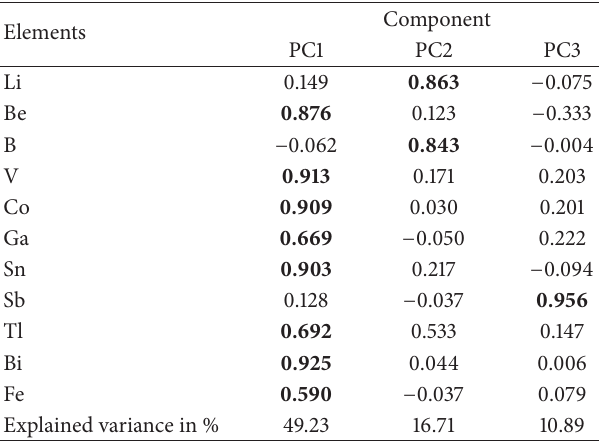
Table 6: Component pattern matrix for varimax rotated PCA analysis for